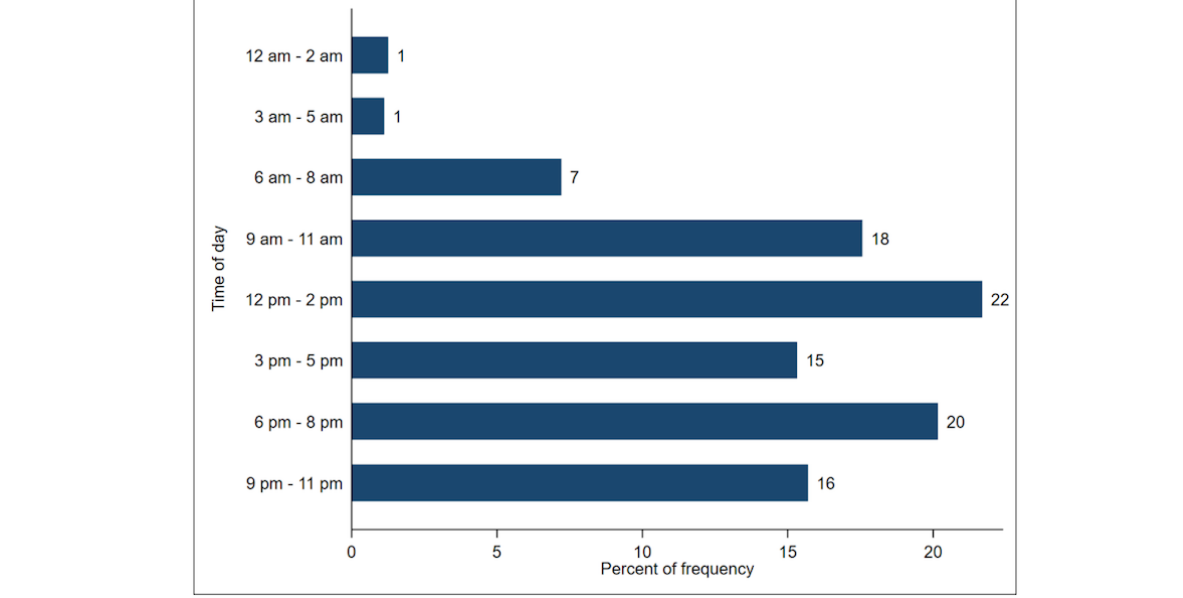
Figure 1. Overall user access time in 3-hour increments.